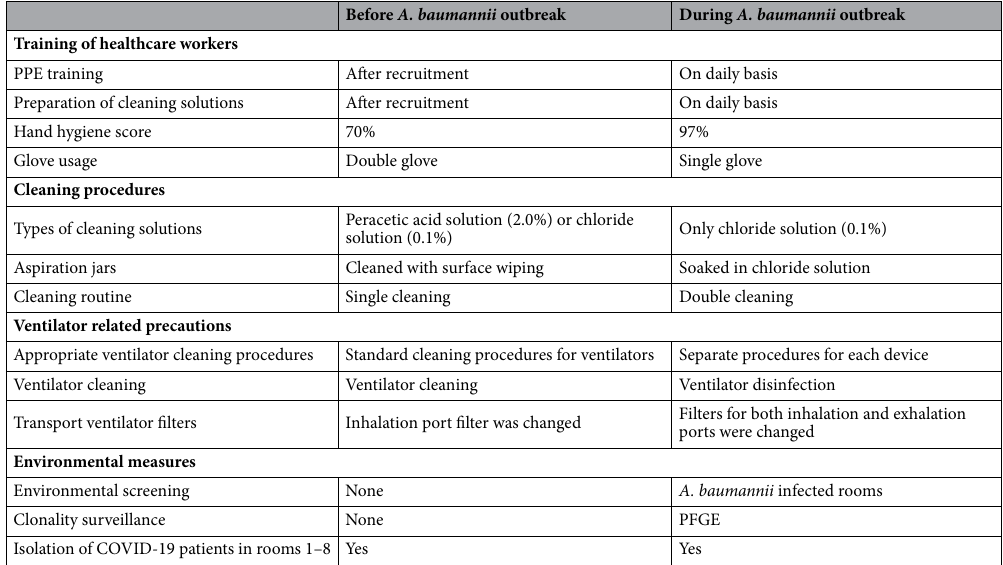
Table 1. Infection control measures before and after A. baumannii